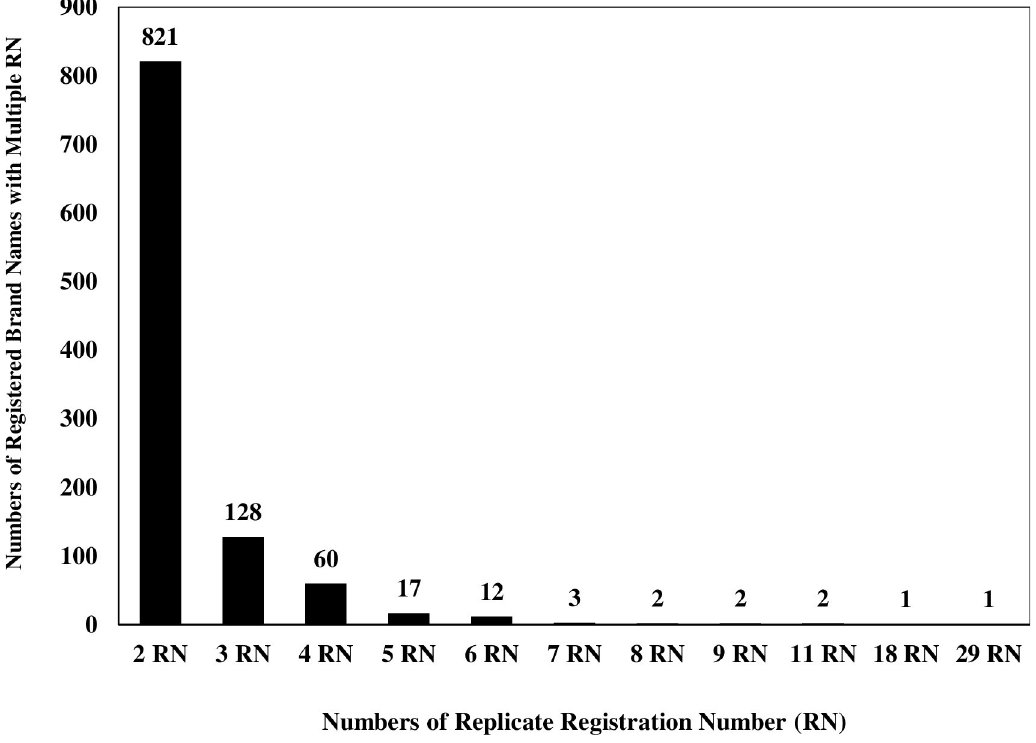
Fig 1. Analogy results of single brand names from single manufacturer having the same active pharmaceutical ingredients (APIs) with numerous registration numbers.